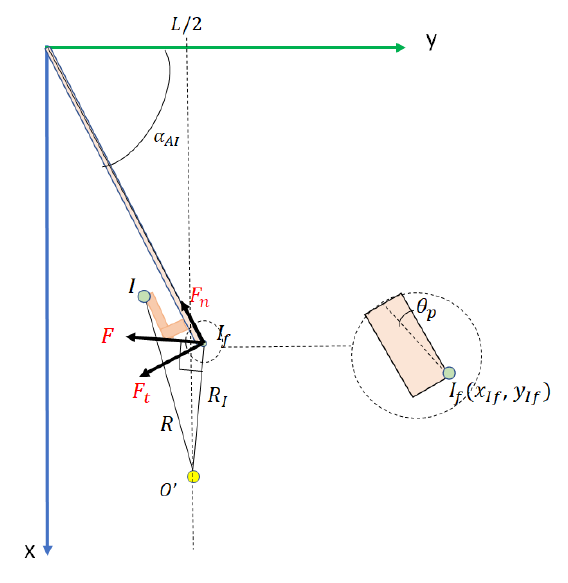
Figure 15. Forces undergone by the door edge at the contact point I f in phase